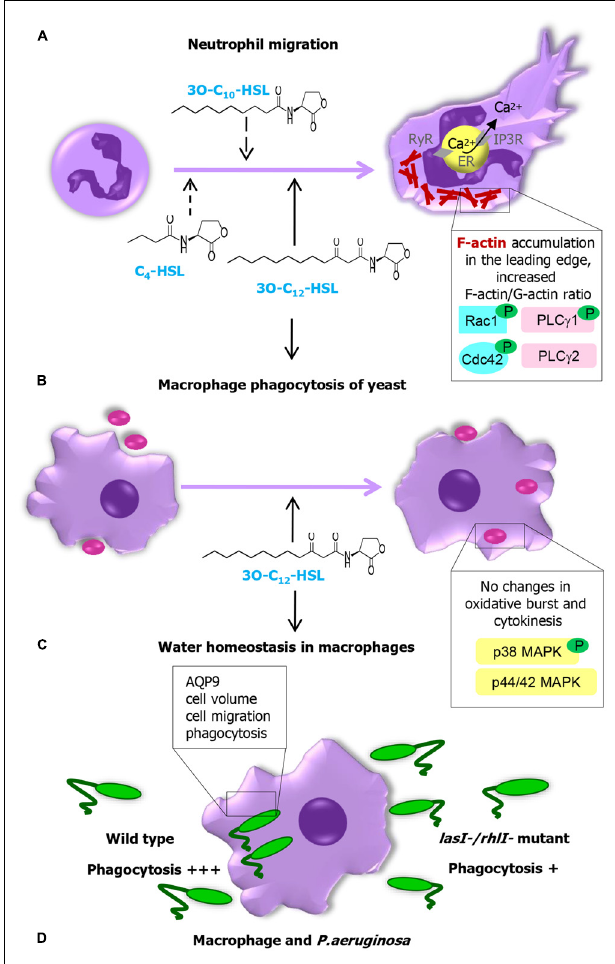
FIGURE 2 | Pseudomonas aeruginosa AHL changes the behavior and function of human innate immune cells and the signaling machinery responsible for the recognition ofAHL. (A) Long chain AHLs are strong chemoattractants for neutrophils. Chemotaxis and migration towards these AHLs are paralleled by cytoskeletal F-actin accumulation in the leading edge and increased F-actin-to-G-actin ratio via activation of small GTPases Rac1/Cdc42, phosphorylation of PLC γ 1 and mobilization of calcium via IP 3 R at ER. (B) 3O-C 12 -HSL and macrophage activity. 3O-C 12 -HSL increases phagocytic capacity of macrophages via the p38, but not p42/44 MAPK, having no influence on their oxidative metabolism, or production of cytokines. (C) 3O-C 12 -HSL-mediated water homeostasis in macrophages. (D) Macrophage phagocytosis of P. aeruginosa wild type and lasI-/rhlI- mutant lacking production of QS molecules 3O-C 12 -HSL and C 4